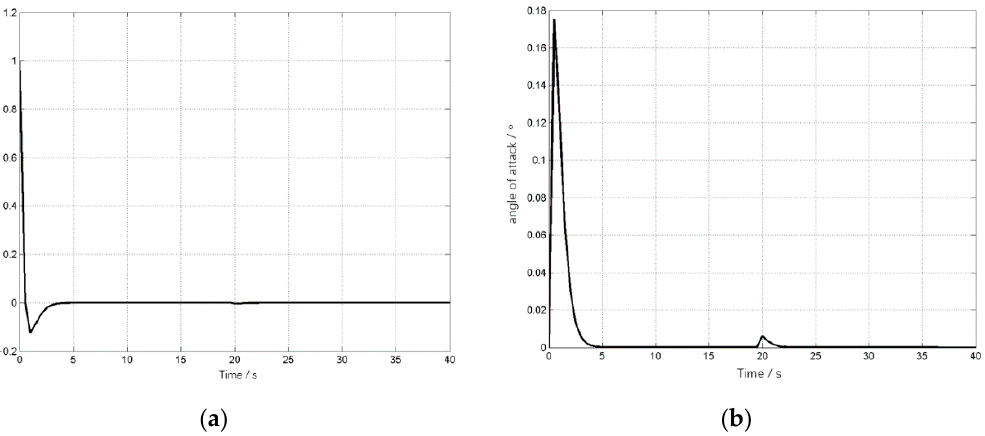
Figure 9. ( a ) State-response graph of the pitching angular velocity with pole assigned; ( b ) state- response graph of the angle of attack with pole assigned.